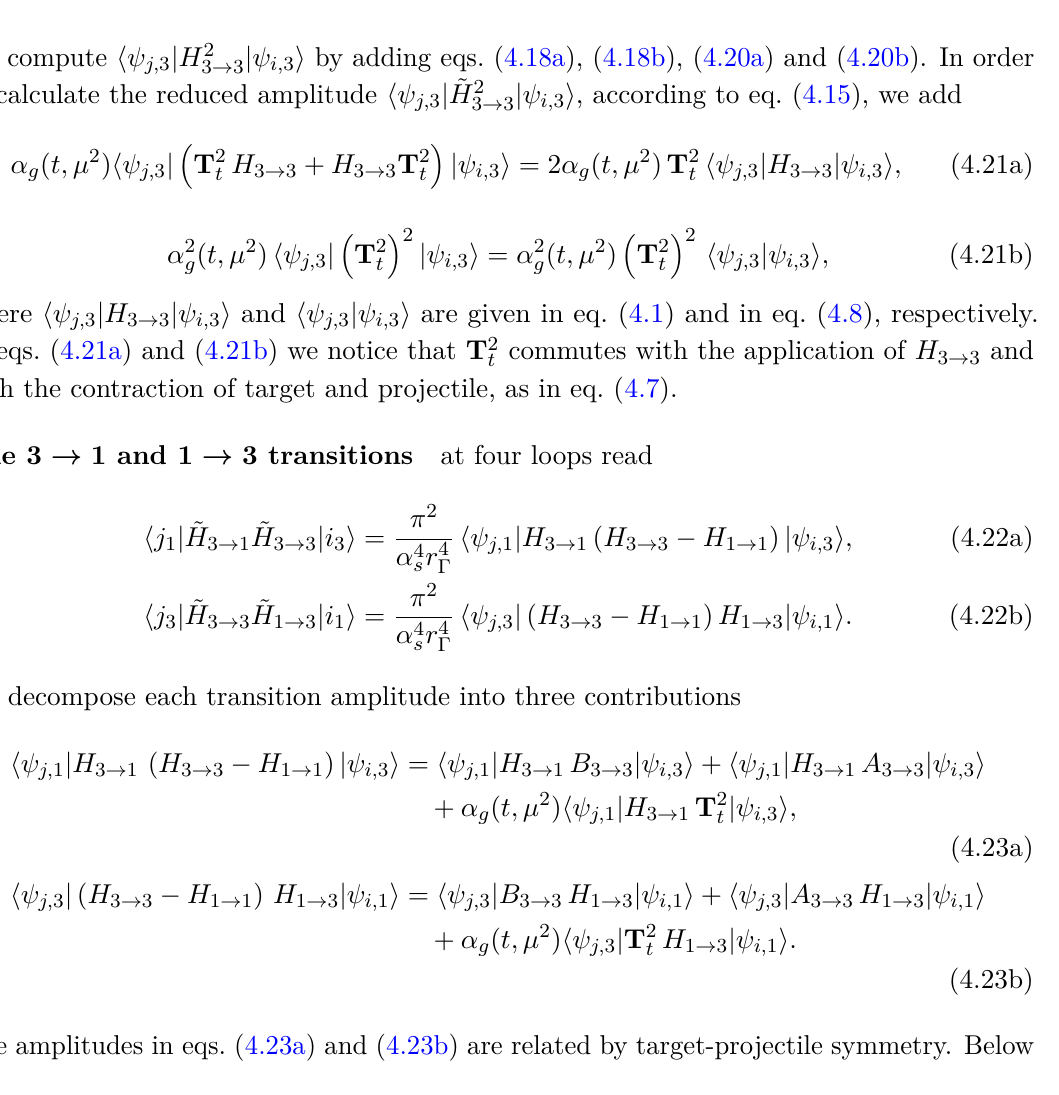
Figure 6. Diagrammatic representation of the first (a) and second (b) terms of eq.